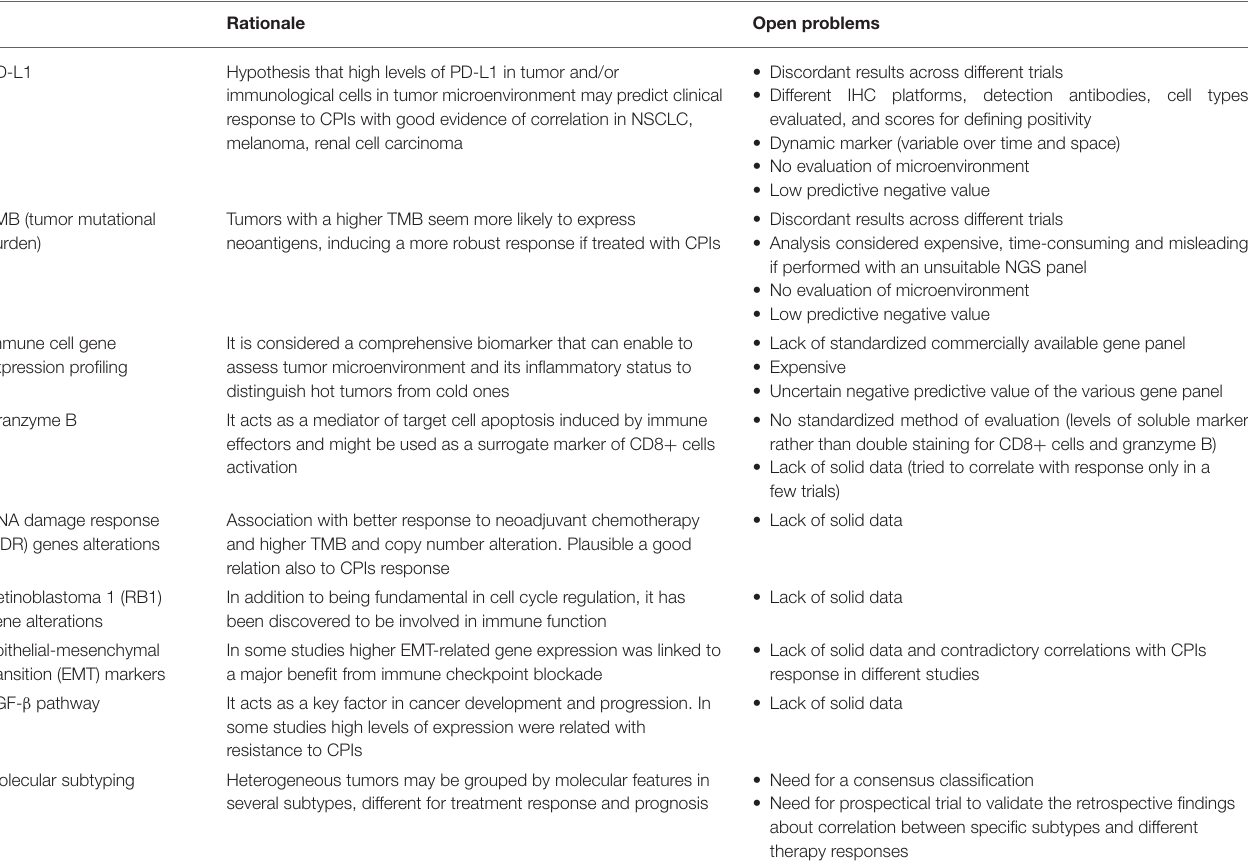
TABLE 6 | Potential predictive biomarkers for immunotherapy with immune